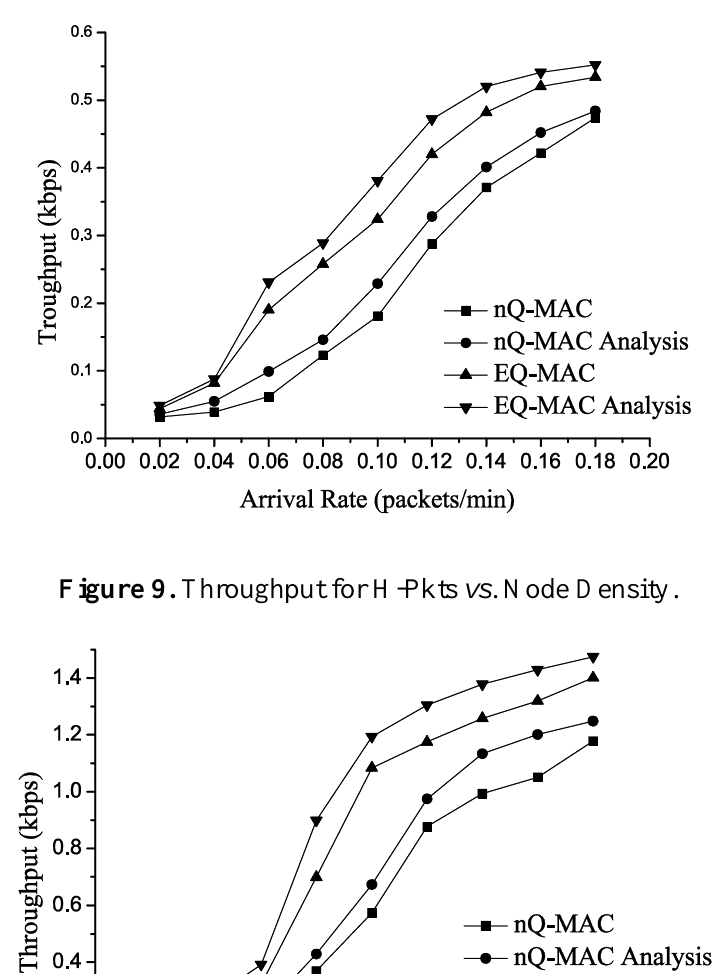
Figure 8. Throughput for H-Pkts vs . Arrival Rate.